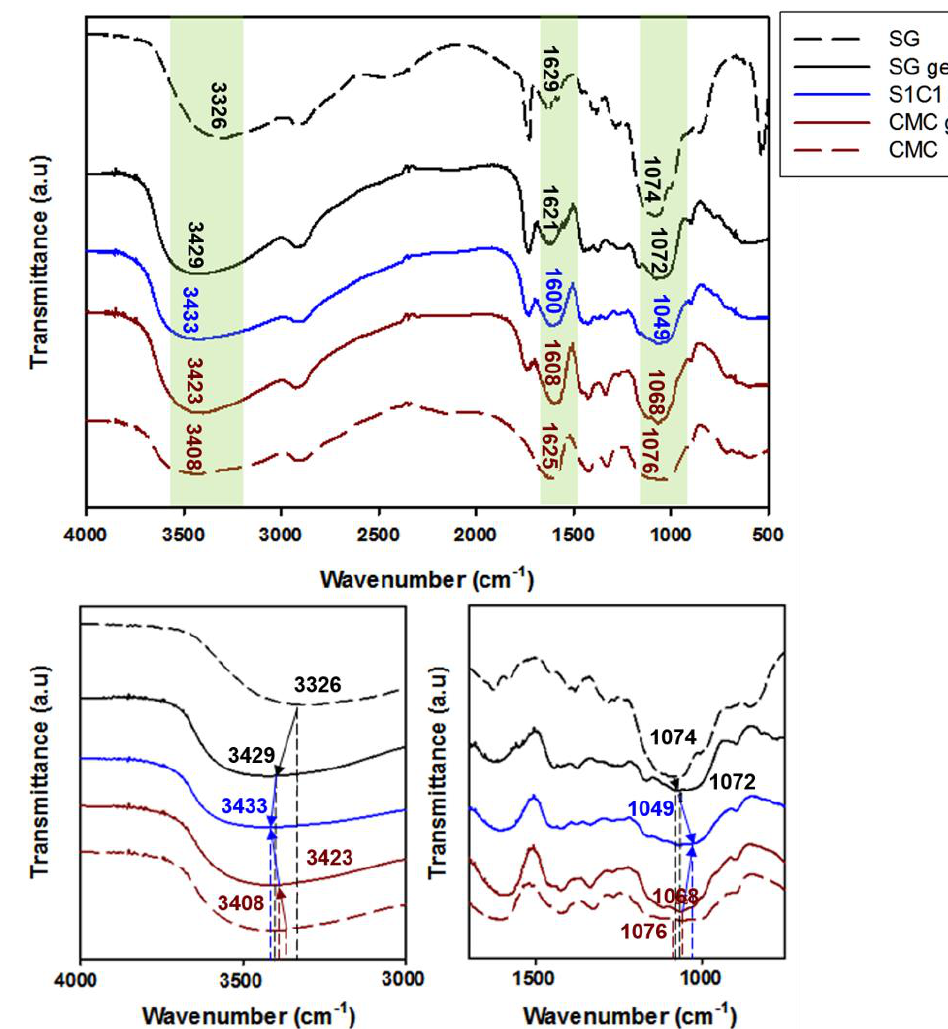
Figure 1. FTIR spectra of SG gel, S1C1 gel, and CMC gel. However, when the Fe 3+ ions are crosslinked with the polymer, the S1C1 gel absorption peaks shifted to 3433, 1600, and 1049 cm − 1 , respectively. When the polymer coordinated with the Fe 3+ ions, the –OH stretching band of the polymer mixture significantly red shifted to 3433 cm − 1 . This proves that the –OH group and Fe 3+ ion of the polymer mixture are coordinated [41]. In addition, the specific peak associated with the carboxyl group was shifted to 1600 cm − 1 , and the asymmetric C-O-C stretching peak by backbone sugar shifted to 1049 cm − 1 . The shift of these peaks is also due to the coordination of the carboxyl group of the polymer mixture with the Fe 3+ ions [42,43]. In conclusion, the Fe 3+ ion was strongly coordinated by hydrogen bonds between the hydroxyl groups and carboxyl groups of SG and CMC. A schematic representation of the presumable coordination mechanism of the SG and CMC polymer solutions and FeCl 3 based on the above findings is shown in Figure